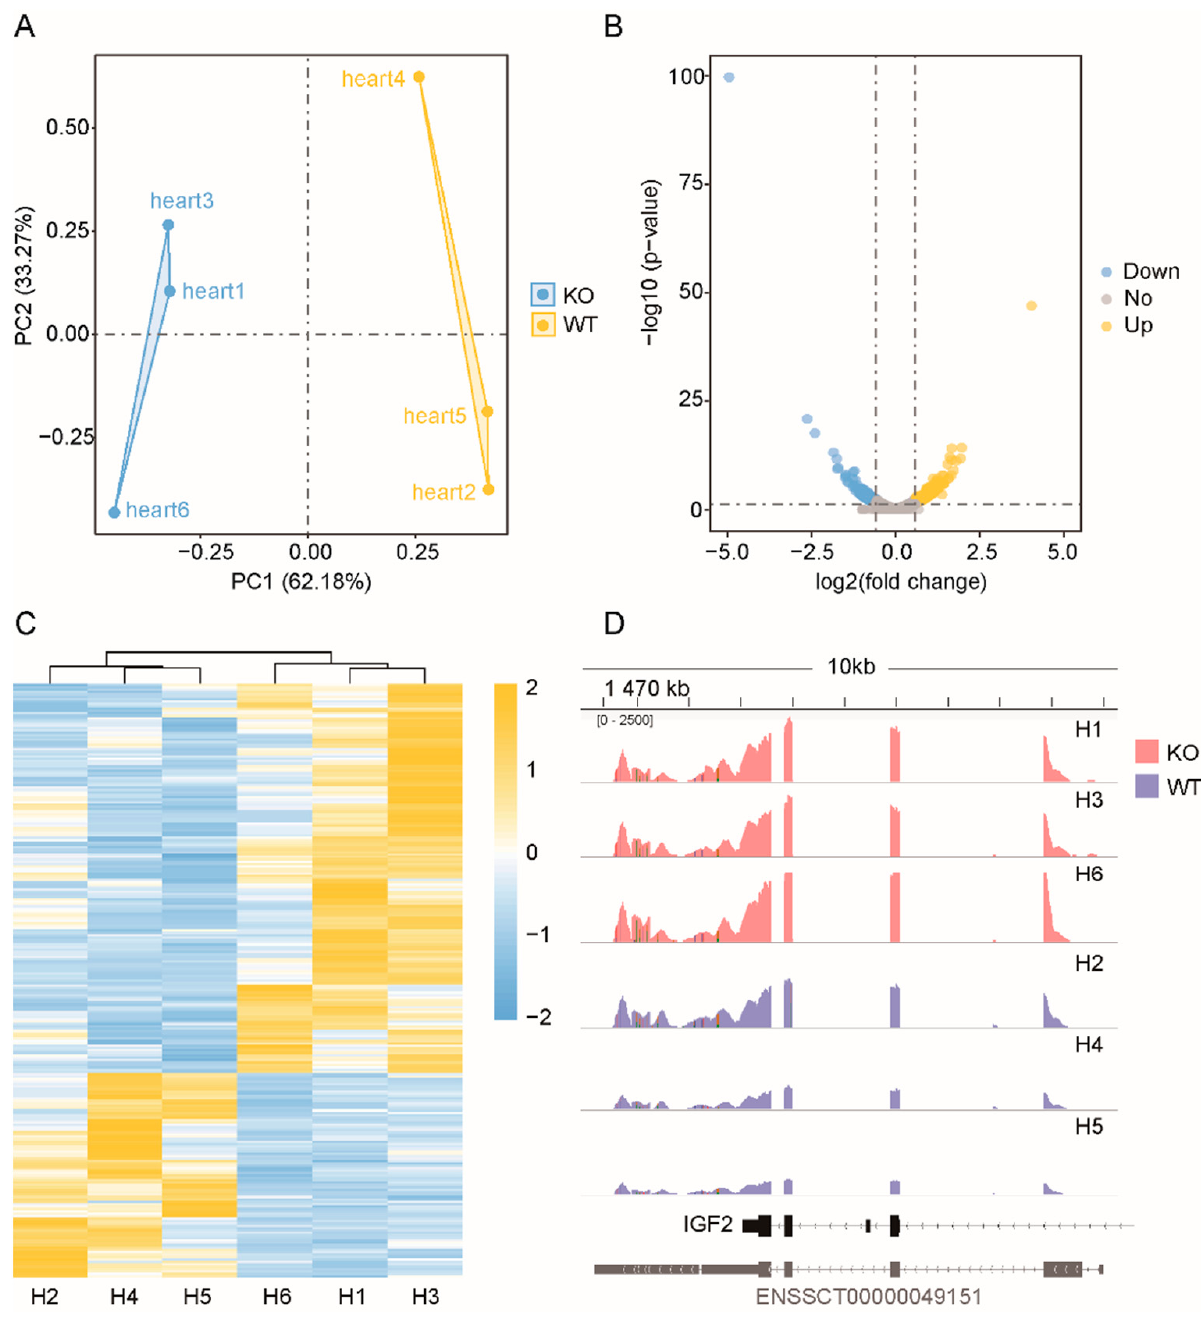
Figure 2. Statistical analysis of the coding genes. ( A ) PCA of all expressed mRNAs. Blue dots represent ZBED6 -KO samples, whereas yellow dots represent ZBED6 -WT. ( B ) Volcano plot of all expressed mRNAs. Blue represents down-regulated DEGs, yellow represents upregulated DEGs and gray represents insignificantly expressed genes. The horizonal dashed black line shows criteria of p -value equal to 0.05, while the vertical dashed lines show log2FC equal to − log1.5 (left) and log1.5 (right). ( C ) Hierarchical clustering of DEGs. The heavier the yellow is, the higher the difference in gene expression is, and the heavier the blue is, the lower the difference in gene expression is. ( D ) Direct comparison of the read counts ( y -axis) from ZBED6 -KO and ZBED6 -WT RNA-seq data across IGF2 regions. The red represents ZBED6 -KO group, and blue represents ZBED6 -WT.